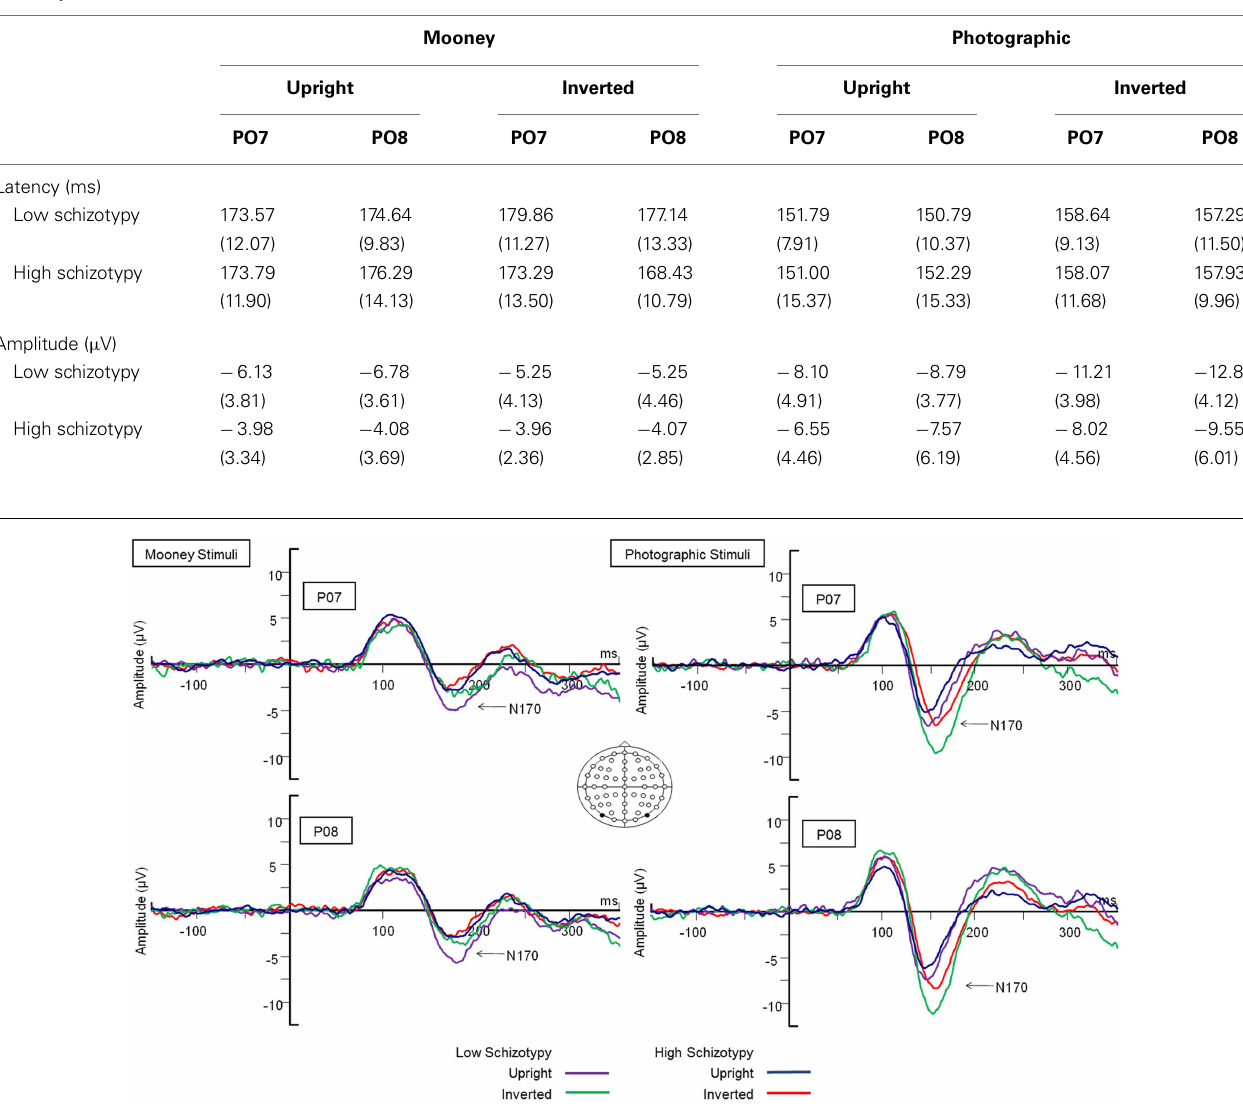
Table 5 | N170 Mean (SD) amplitude and latency per condition and electrode .